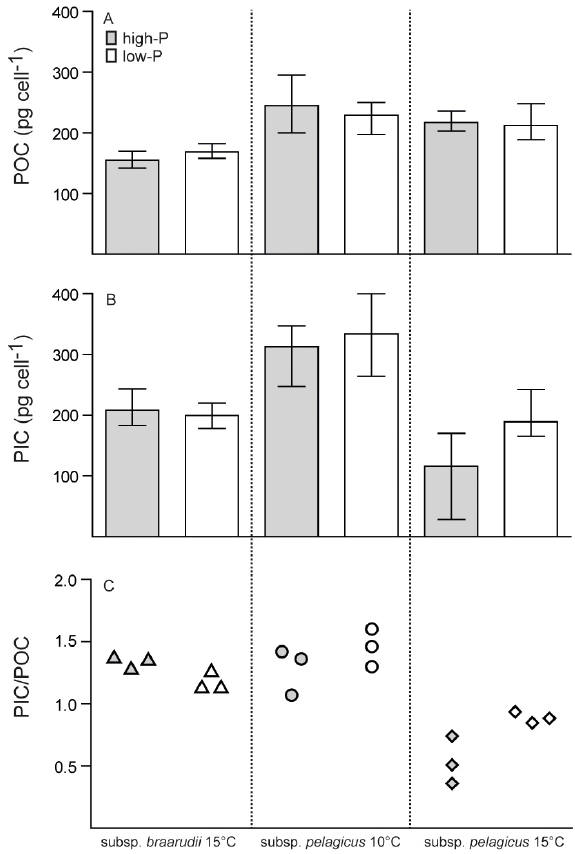
Figure 2. (A) Particulate organic carbon (POC) quotas of Coccolithus pelagicus subsp. braarudii grown at 15 ◦ C and subsp. pelagicus grown at 10 and 15 ◦ C, in high-P and low-P medium. (B) Particulate inorganic carbon (PIC) quotas. (C) PIC/POC ratios. Mean ± min/max. Values are from main experiments only, n = 3.